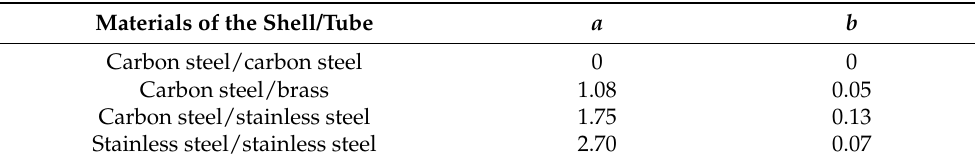
Table 2. Different a and b values in Equation (24) with respect to different materials of construction in shell-and-tube heat exchangers [36].